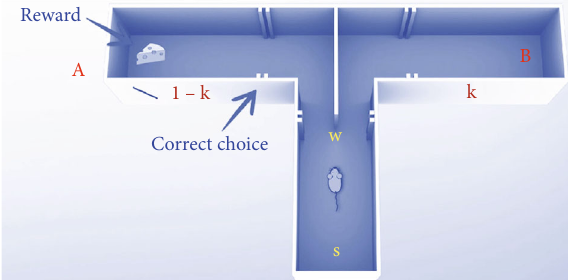
Figure 1: The behavior of a rat in a T-maze experiment.